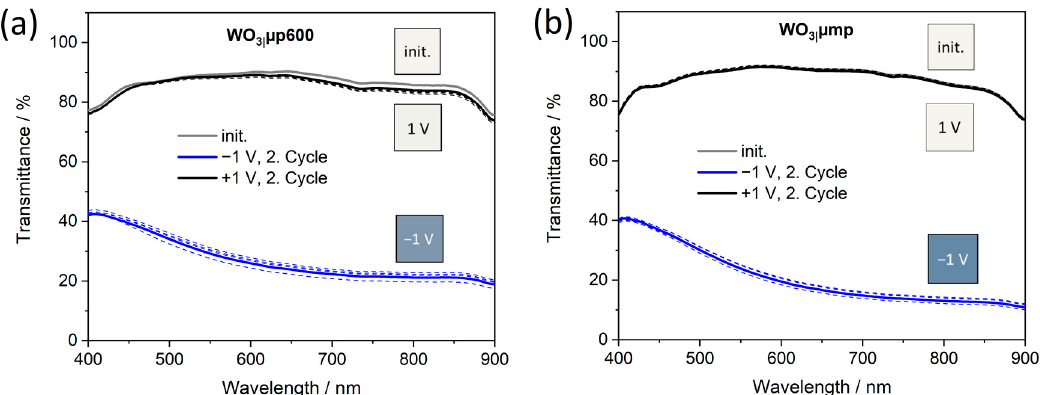
Figure 7. Transmittance spectra of ( a ) WO 3| µ p600 and ( b ) WO 3| µ mp thin films measured in contact to LiClO 4 in PC at a scan rate of 5 mV s − 1 in the initial state (init.), in the bleached (1 V) and in the colored ( − 1 V) states. The insets show the calculated color impressions for the second cycle of the films.